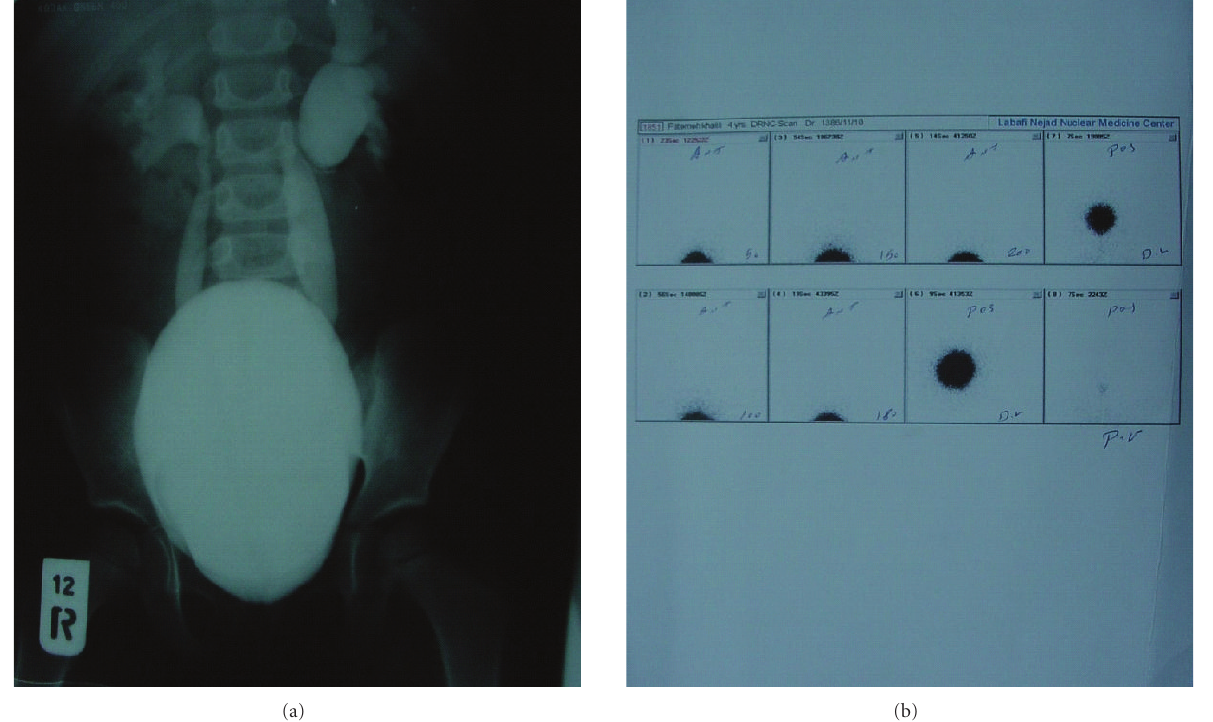
Figure 1: (a) Preoperative voiding cystoureterogram of a patient with bilateral high-grade vesicoureteral reflux. (b) Postoperative RNC of the patient reveals reflux resolution.